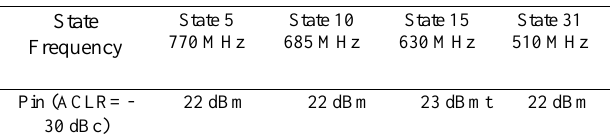
Table 1. Measured power at the input of the tunable antenna for